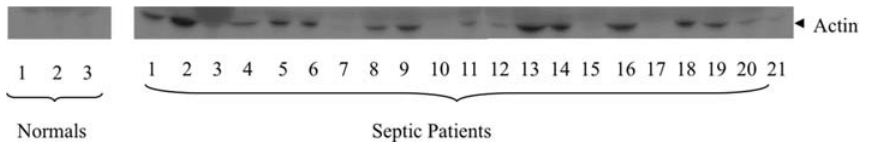
Figure 1. Actinemia occurs in human sepsis. Western Blot (WB) of plasma from septic patients and normals staining for actin shows that actin is present in the plasma of 17/21 patients, while Western Blot of three representative normals had no detectable actin in circulation.